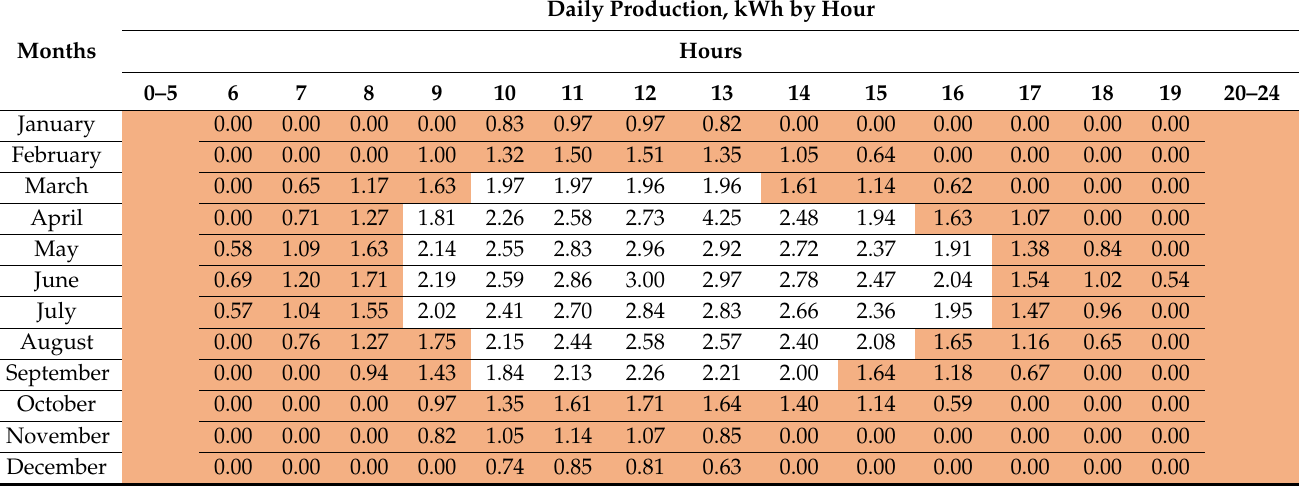
Table 18. Hours during which the power generated by the designed photovoltaic system will be sufficient for effective use of the kettle (not including system degradation). The hours when there is not enough electricity produced by the photovoltaic system are marked in